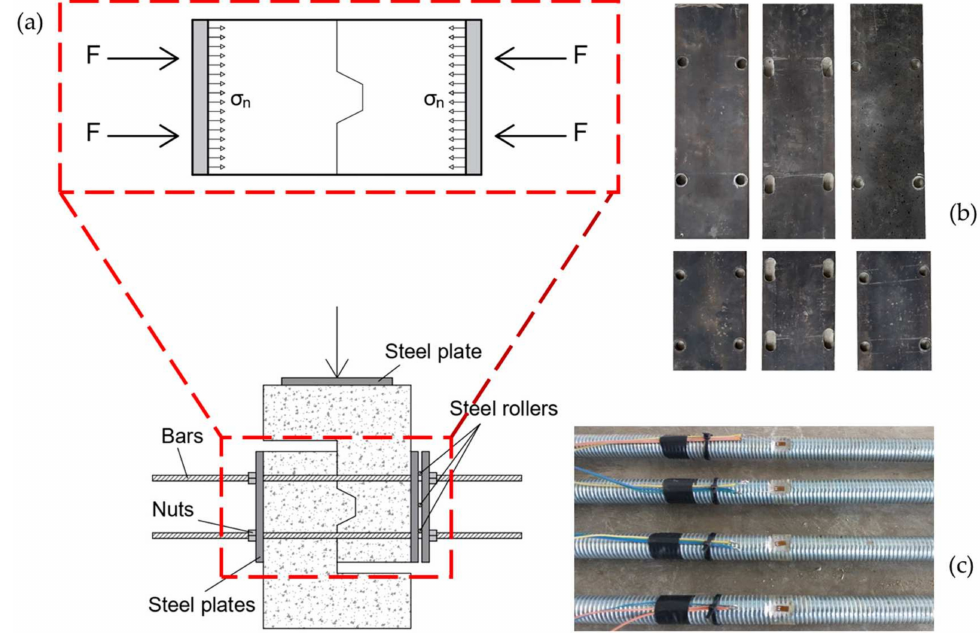
Figure 10. ( a ) schematic of the confinement system, ( b ) metal plates used to apply the confinement stress, and ( c ) steel bars instrumented to generate the reaction force on the